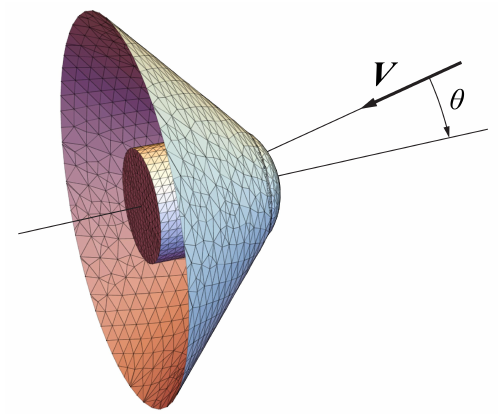
Figure 2. Example